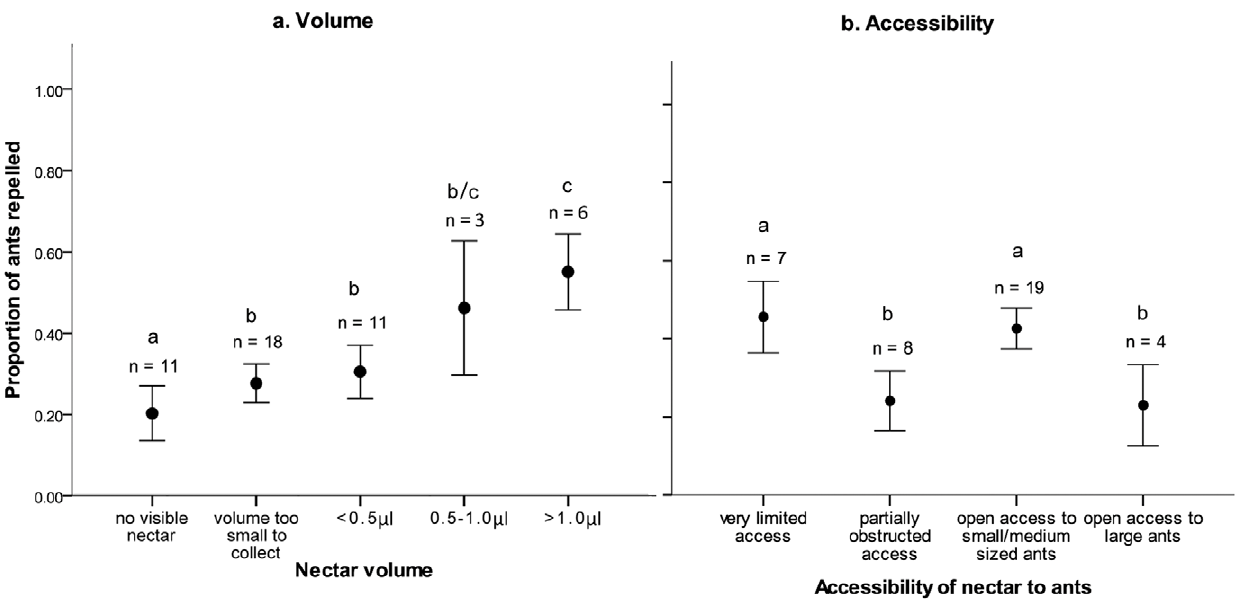
Figure 2. Tactile ant-repellence, nectar volume and nectar accessibility. a) Significant differences in ant-repellence occurred between plants with different volumes of nectar ( x 2 =42.9, df=4, p , 0.001) with a significant positive trend between nectar volume and the proportion of ants repelled (J-T=5.9, df=4, p , 0.001). b) Ant-repellence differed significantly between plants with different levels of accessibility to nectar ( x 2 =26.6, df=3, p , 0.001), although the negative trend between accessibility and repellence was not significant (J-T= 2 1.5, df=3, p=0.13). Significant differences between groups indicated with a/b/c. Error bars indicate 95% confidence intervals.